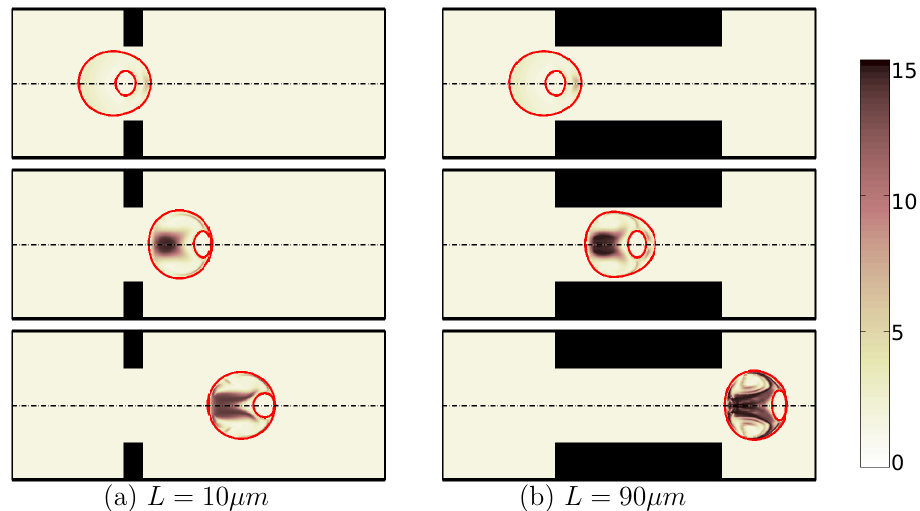
Figure 9. Shape evolution of an encapsulated HL60 cell through constricted microchannels with L = 10 µ m ( a ) and L = 90 µ m ( b ) at different locations of channel. The color bar and contours represent the square root of trace of conformation tensor inside the cell and the shell fluid. ( λ = 0.1 s, β = 0.5, Ca = 0.00076 and Re = 0.37).